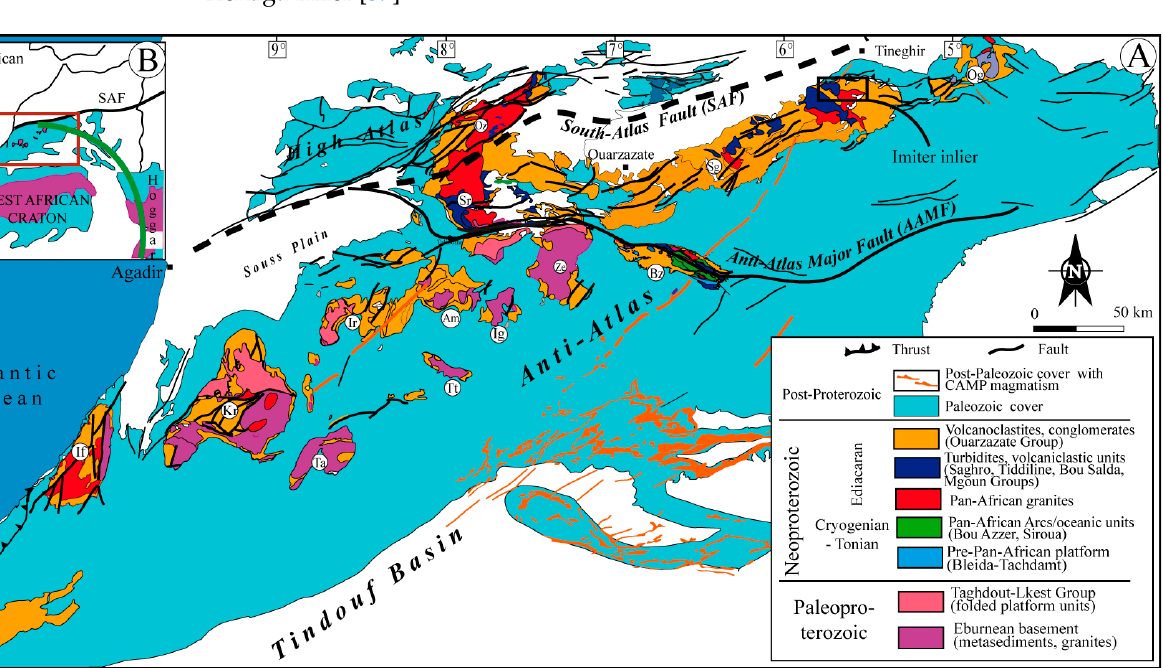
Figure 1. ( A ) Simplified geological sketch map of the Anti-Atlas belt (after [29]). ( B ) The inset shows the location of the Anti-Atlas domain north of the West African Craton. Abbreviations: Og = Ougnat; Sg = Saghro; Bz = Bou Azzer; Ze = Zenaga; Tt = Tagrara Tata; Sr = Sirwa; Oz = Ouzallarh; Ig = Ighouda; Am = Agadir Malloul; Ir = Ighrem; Ta = Tagrara Akka; Kr = Kerdous; If = Ifni; Bd = Bas Draa.